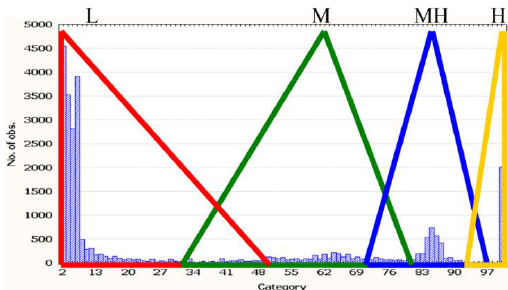
Figure 5. Quantity features need to be quantized before coded to AIS antibodies. We use histogram to help fuzzy quantizing the quantity values to four categories. Table 3. Coding scheme for assigning values to categorical features.